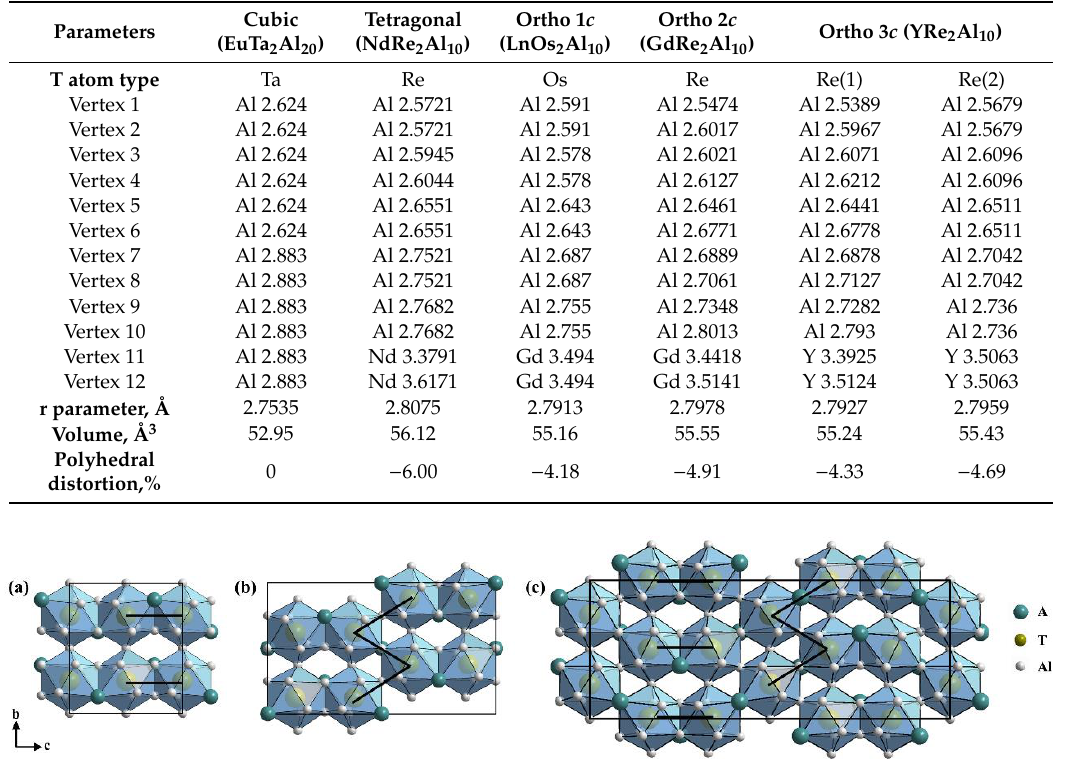
Table 6. Calculation of the degree of distortion of the icosahedron formed around T atom in the discussed structures. Following [60], r parameter is the average distance from the center to the vertices of the coordination polyhedron. Distances are given in Å . For calculations, atomic models of EuTa 2 Al 20 , NdRe 2 Al 10 , LnOs 2 Al 10 , GdRe 2 Al 10 and YRe 2 Al 10 (taken from [34]) were used as prototypes of cubic, tetragonal and 1 c , 2 c , 3 c orthorhombic structures, respectively, containing A and 5 d T atoms.